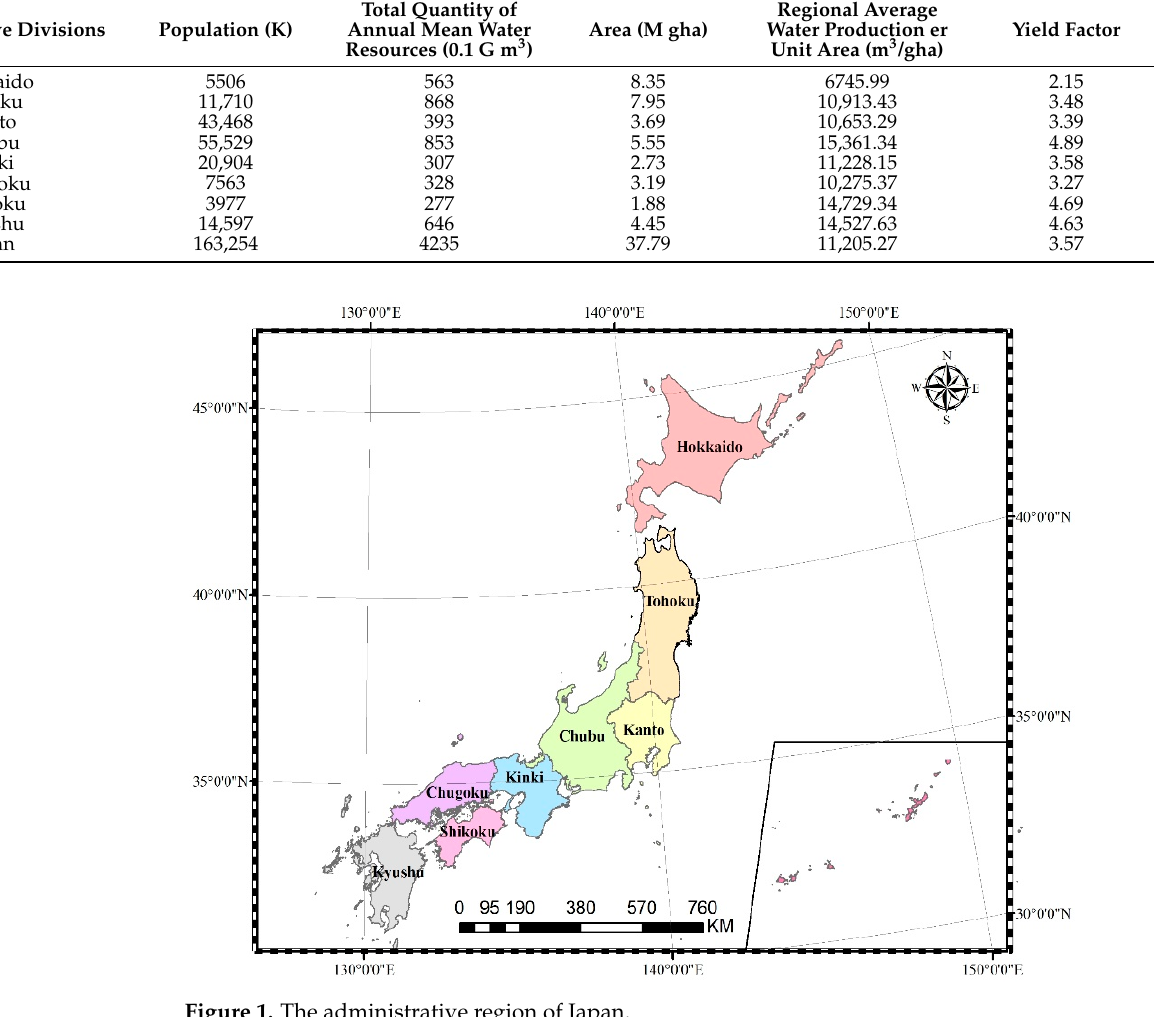
Figure 1. The administrative region of Japan.